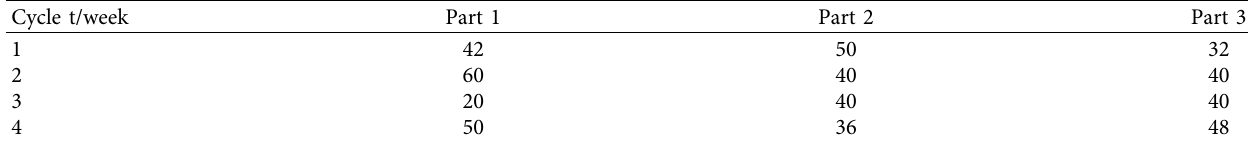
Table 4: Parameter